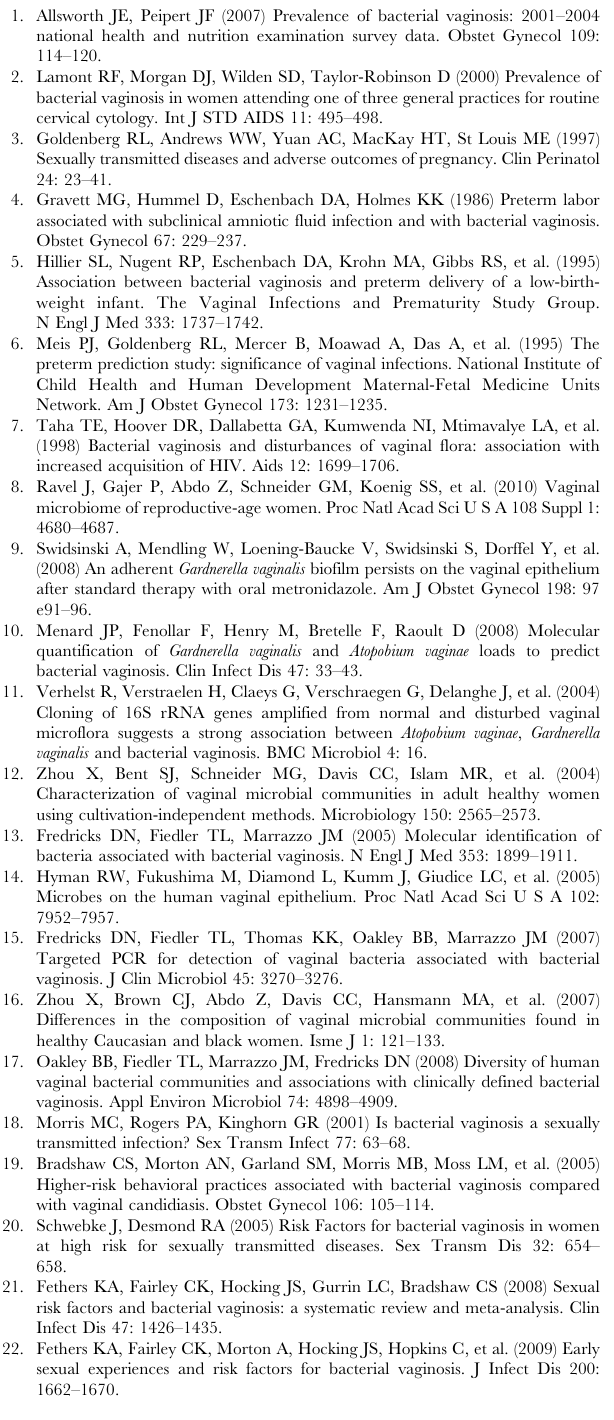
Table S6 Summary of major findings relating BV candidate organisms to BV status and sexual risk